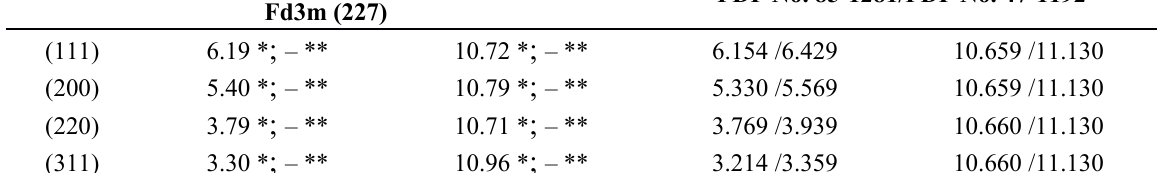
spacing and a lattice parameters for γ , γʹ , metallic ( hkl ) 0